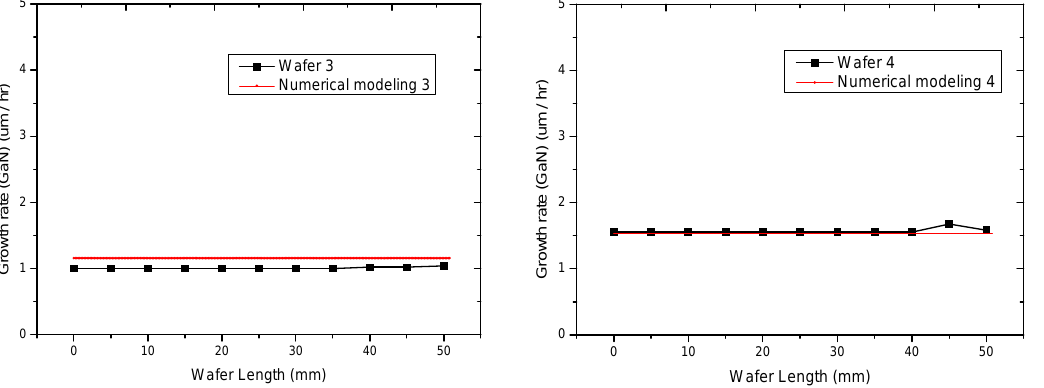
Figure 7. Predicted growth rate for wafers 3 and 4 vs. experimental results.